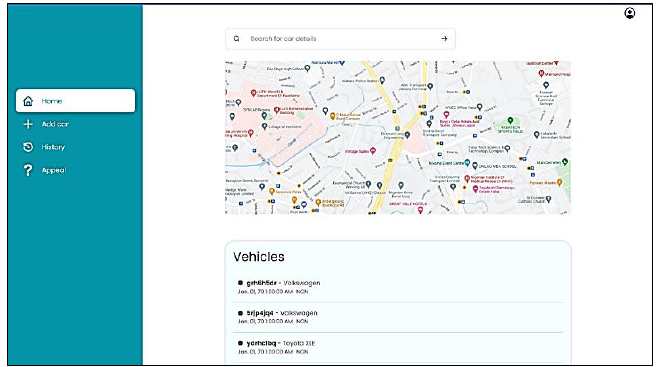
Figure 2: Home Page.